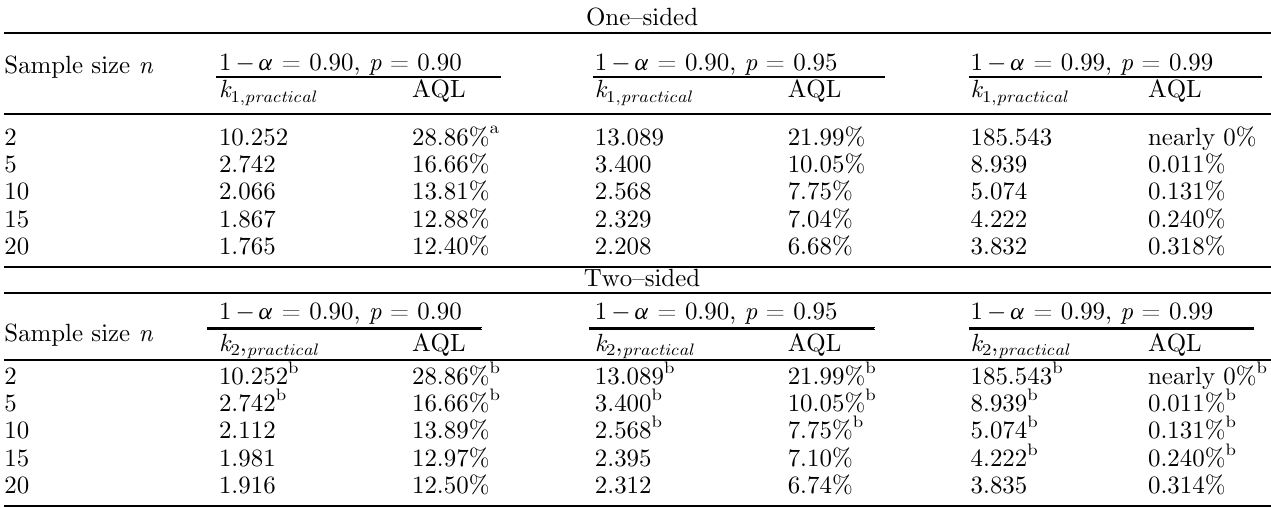
and k 1,practical 2,practical. One – sided